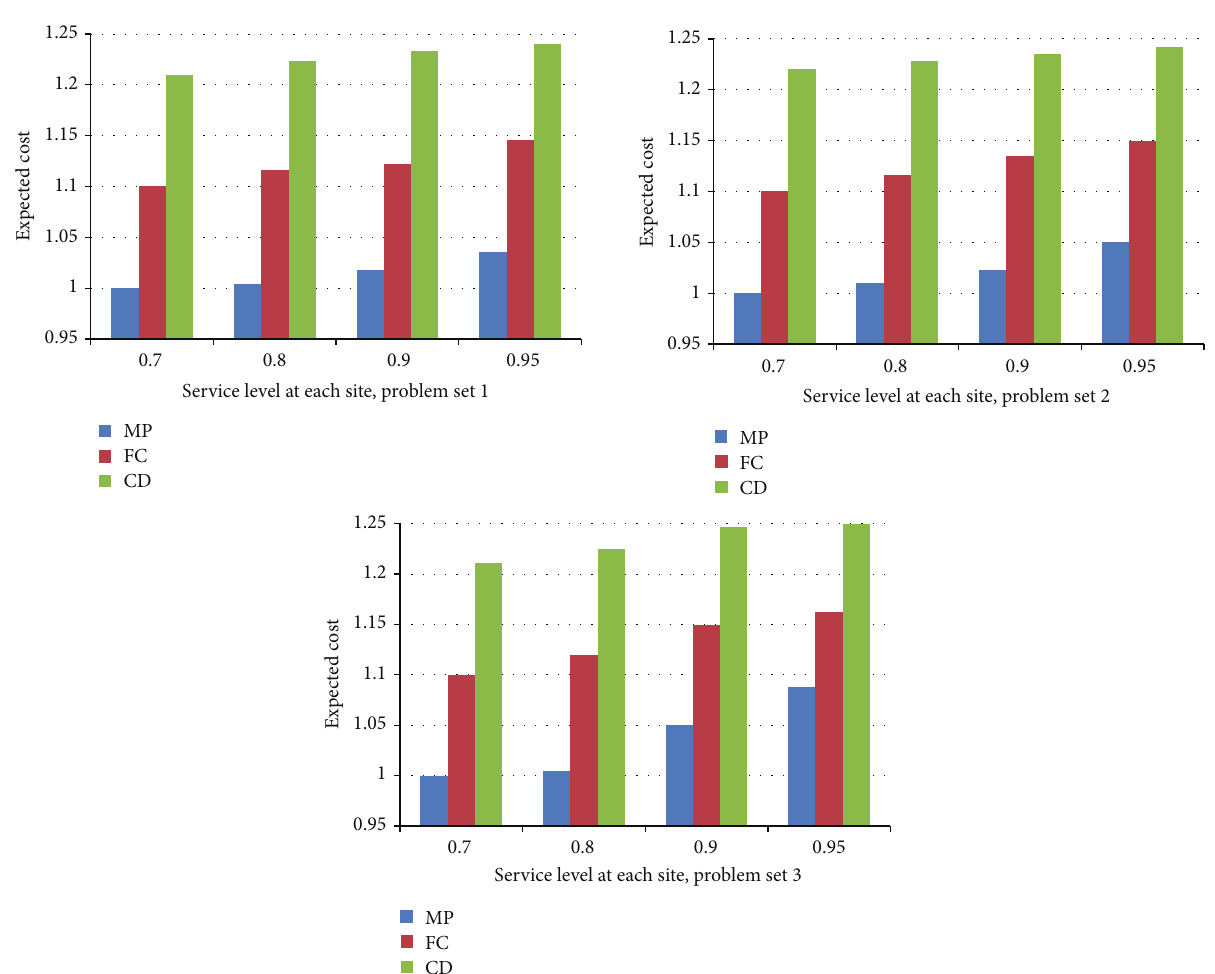
Figure 7: Relative total cost against service level in each site under various policies (MP, CD, and FC), problem sets 1, 2, and 3. Note: total costs are represented relative to the cost at service level equal to 70% under MP